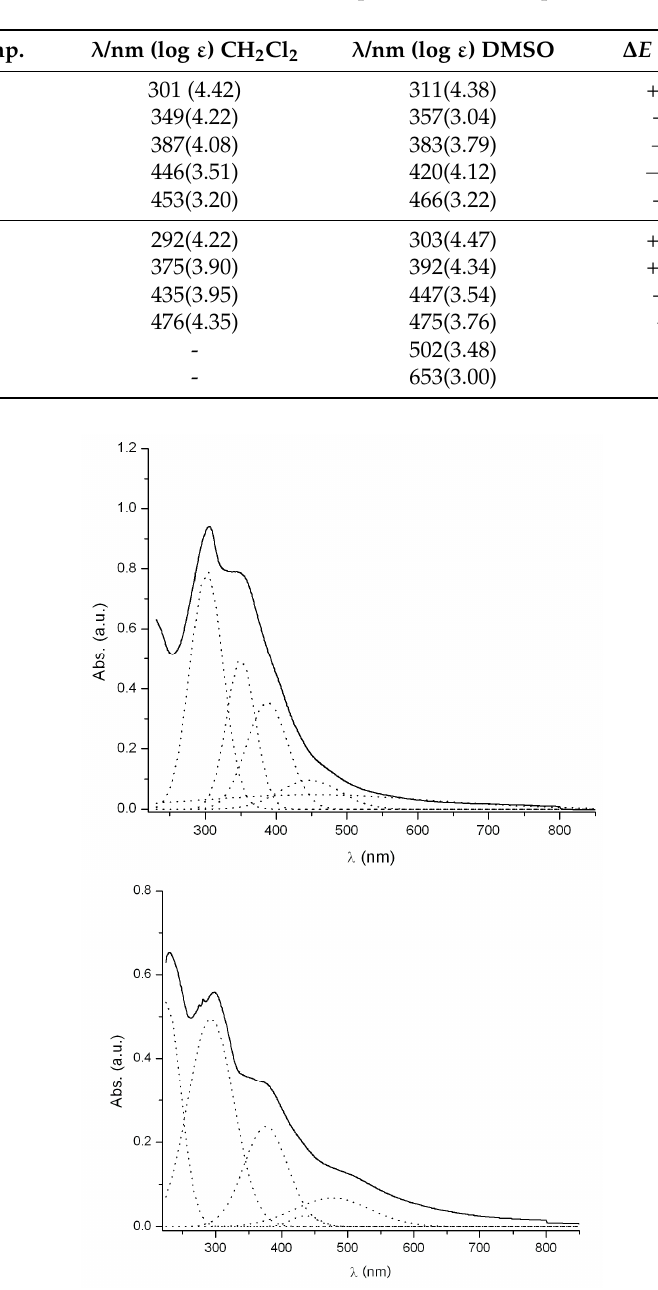
Figure 3. Experimental UV-Vis spectra of complexes 3 ( top , full line) and 5 ( bottom , full line) recorded in CH 2 Cl 2 at 20 °C, and their respective deconvoluted spectra (dotted lines).